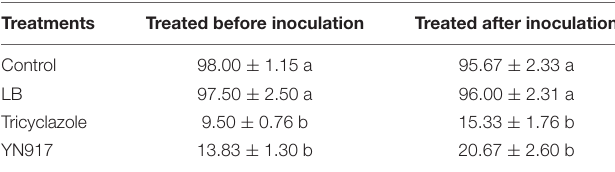
TABLE 3 | Incidence rate of leaf blast development 5 days after inoculation with strain Bacillus cereus YN917 following protective and therapeutic droplet